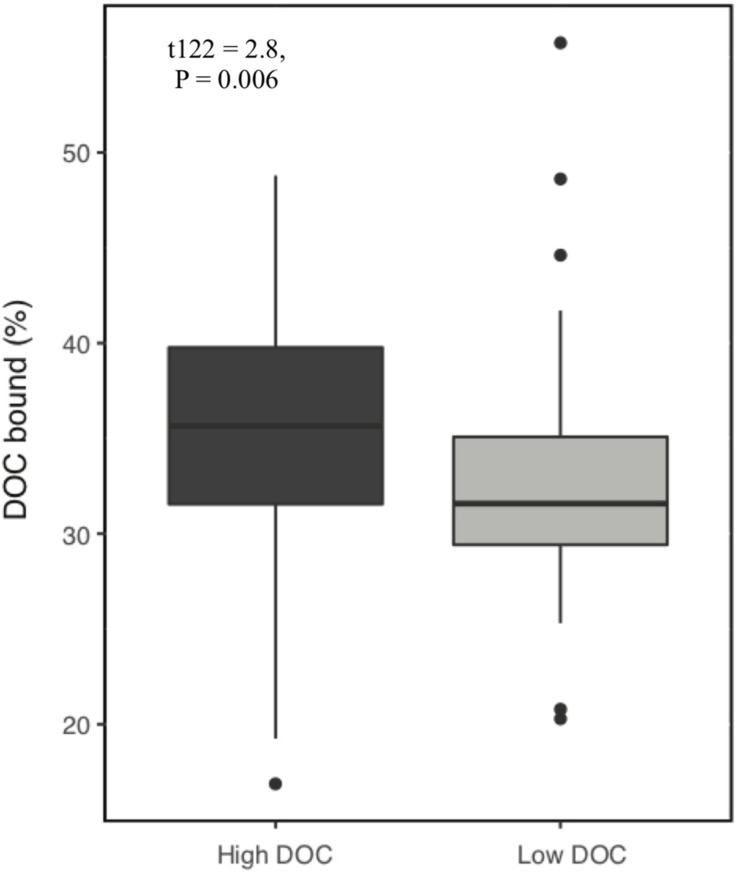
Proportion of dissolved organic carbon (DOC) that binds to aluminum oxide. DOC was obtained from microcosms after 44 days of pine litter decomposition. A greater proportion of DOC binds from high DOC than low DOC samples (P = 0.006, n = 128).